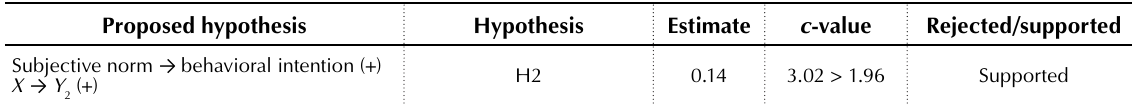
Table 2. Path coefficient for subjective norm have a positive and significant effect on behavioral intention for tax compliance